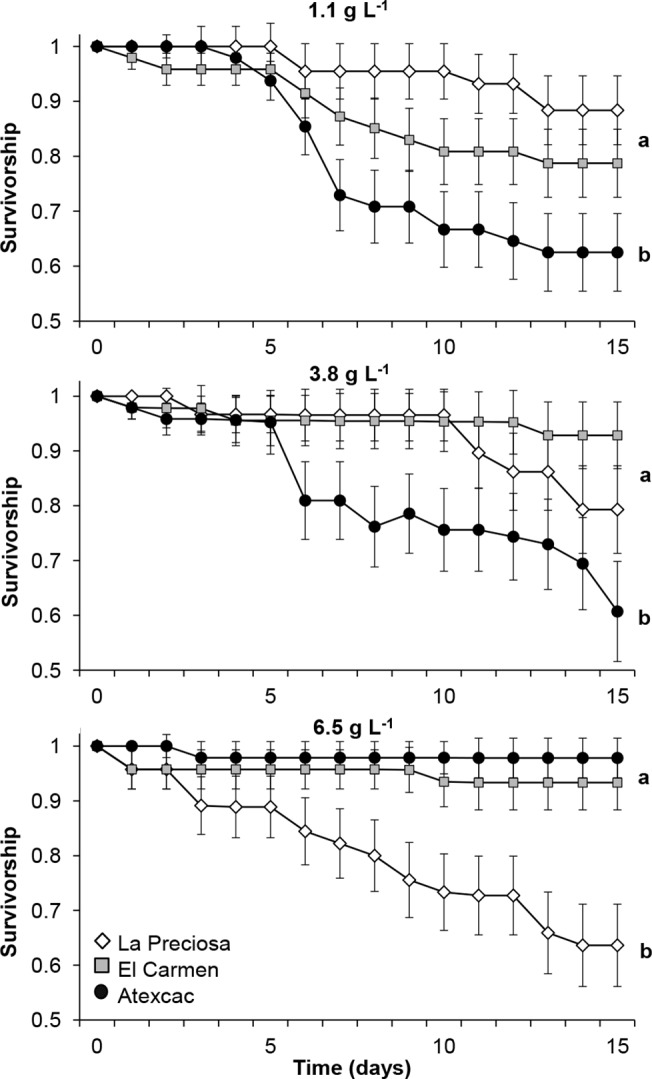
Survivorship curves of three populations of L. cf. sicilis at home and alternative salinities.Values are means ± SE; letters indicate significant differences among populations according to the log-rank tests (P ≤ 0.05).